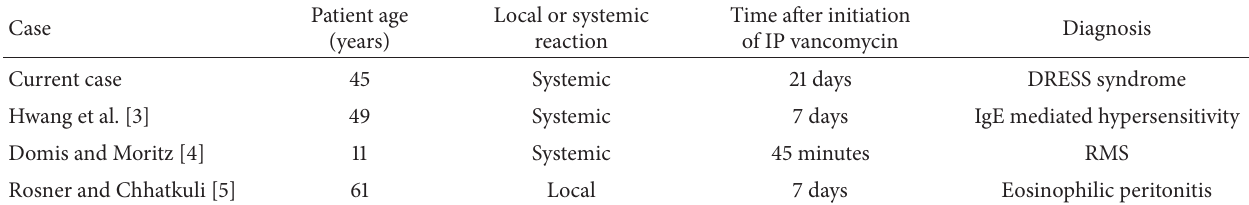
Table 2: Reported local and systemic reactions to IP